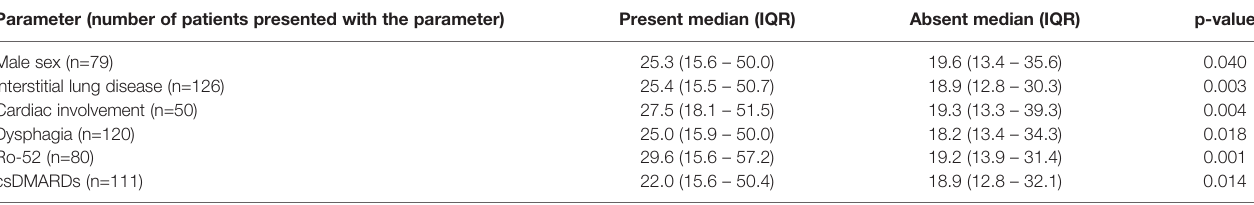
TABLE 3 | Elevated plasma Hsp90 in subgroups of patients with IIM. Parameter (number of patients presented with the